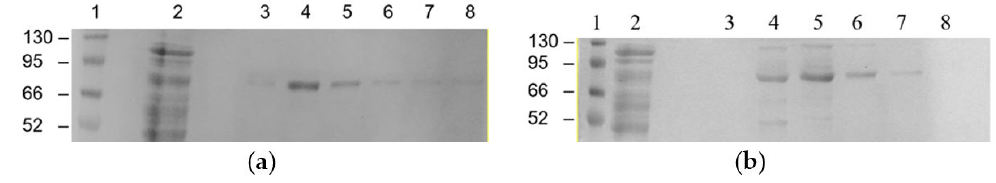
Figure 5. Purification and Coomassie Blue-stained ( a ) M2e-NP and ( b ) mM2e-NP using the ProBond Affinity Purification column. Lanes 1, Blue Ultra Pre-stained protein ladder (Cleaver Scientific, Rugby, UK); 2, crude lysate; 3–8, elution fractions (0.5 mL each).